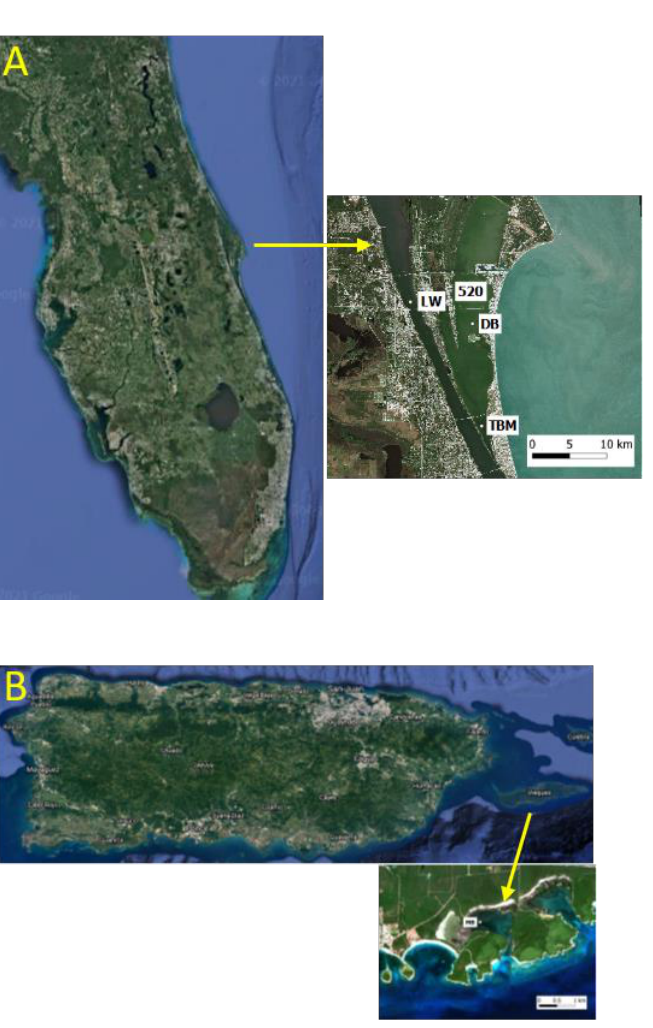
Figure 1. Map depicting sampling sites in ( A ) Indian River Lagoon, FL and ( B ) Mosquito Bay in Vieques, Puerto Rico. Florida sampling sites: TBM = Telemar Bay Marina, DB = Diamond Bay, LW = Lee Wenner Park, 520 = 520 Bridge. MB (Vieques map) = Mosquito Bay.